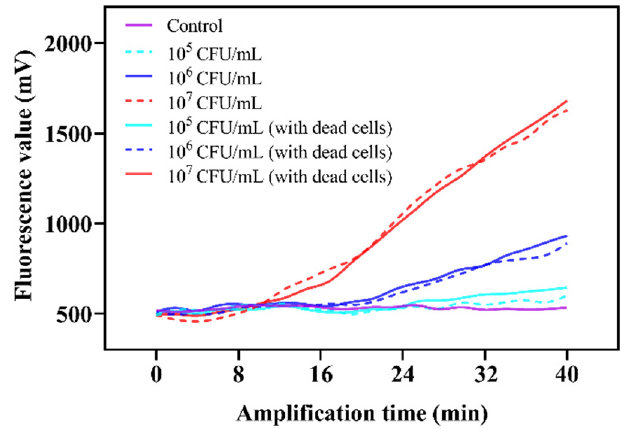
Figure 6. Evaluation of the anti-interference ability for dead Salmonella based on the TOMA–RAA method. The concertation of dead Salmonella was 10 6 CFU/mL in method. The concertation of dead Salmonella was 10 6 CFU/mL in PBS.